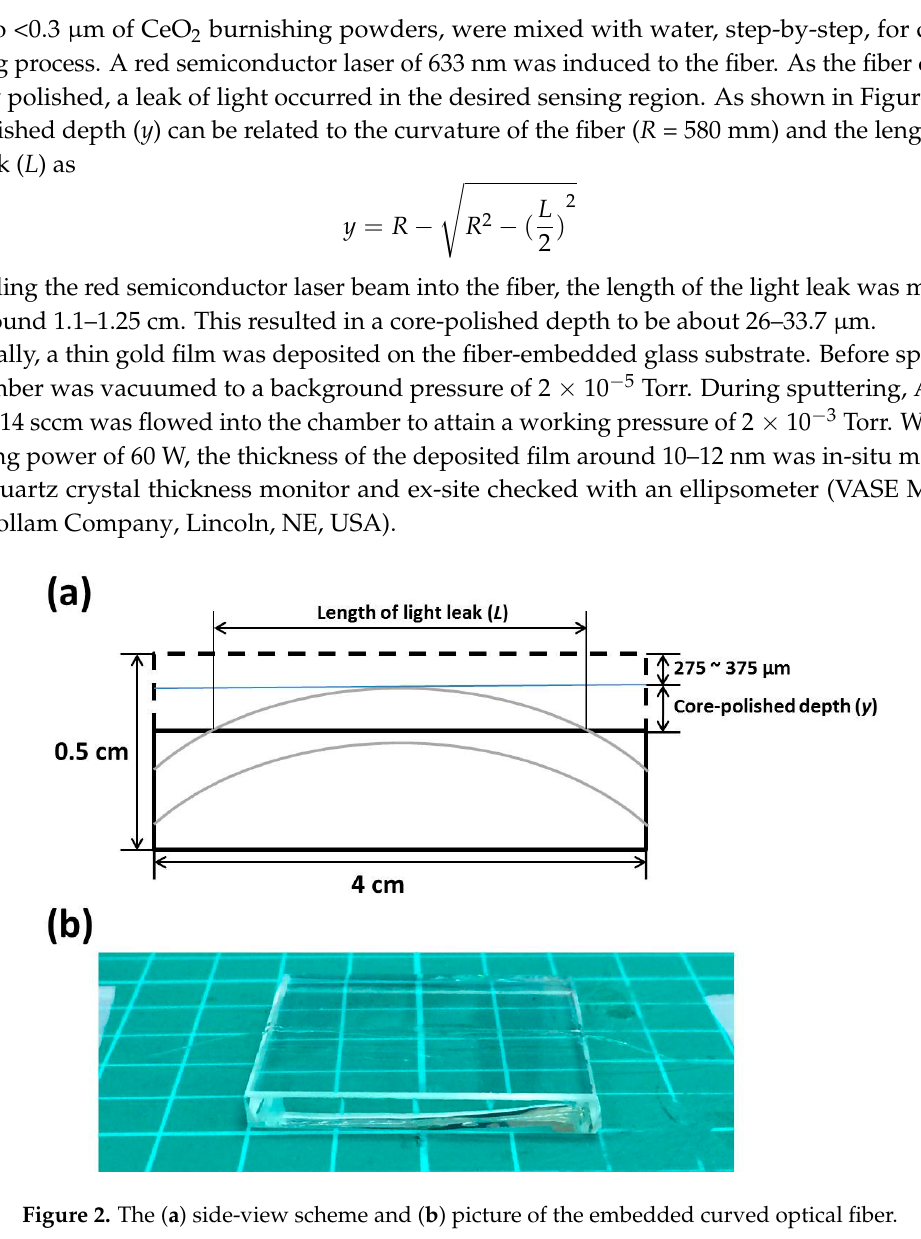
Figure 2. The ( a ) side-view scheme and ( b ) picture of the embedded curved optical fiber.